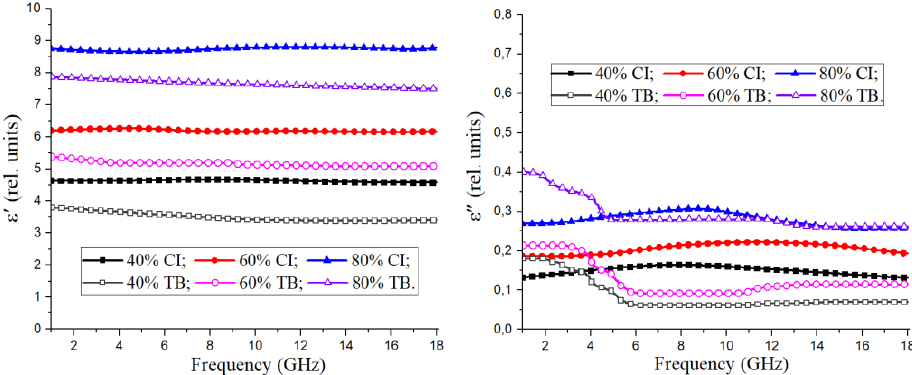
Fig. 3. Frequency dependence of the complex permittivity of a single-component composite based on carbonyl iron and barium titanate.